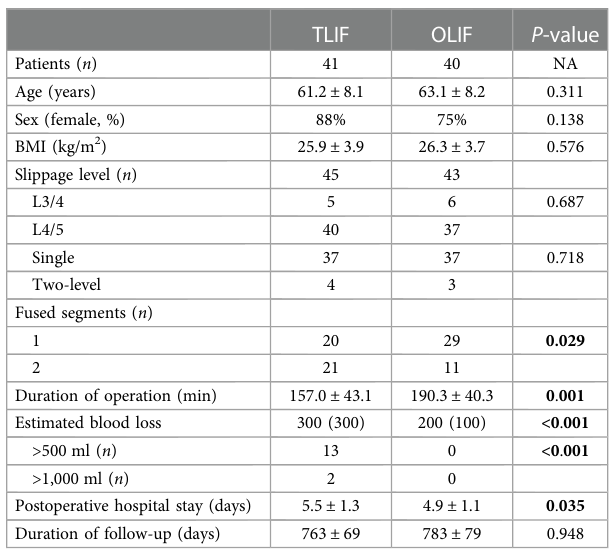
TABLE 1 Patient characteristics in OLIF and TLIF groups a .